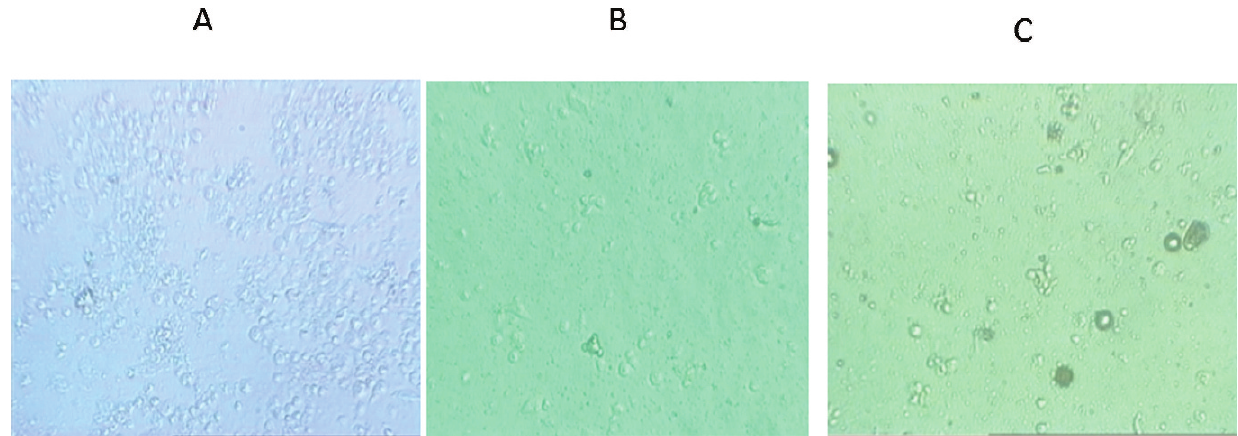
Figure 3 - Cytotoxic effects of chrysin on cell viability of PC-3 cells. Morphological changes of cells after treatment with different concentrations of chrysin 48 hours post-treatment. A) Normal cells; B) 10 m M; and C) 40 m M.